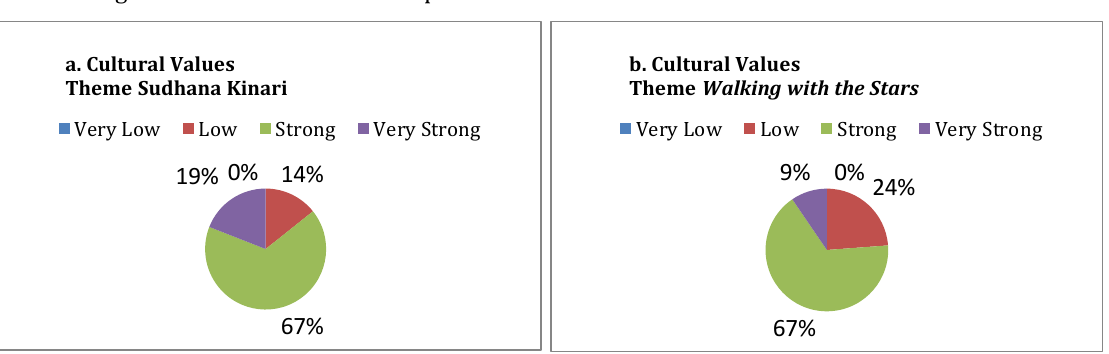
Fig. 1 Cultural Values Theme 1; a Sudhana Kinari , b Walking with the